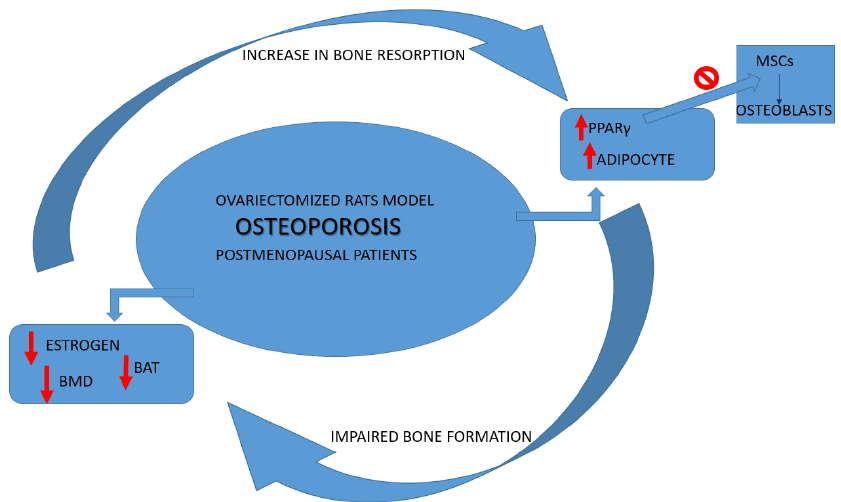
Figure 1. Osteoporosis cycle alterations. BAT: adipose tissue browning; PPARγ: proliferator-activated receptor gamma; BMD: bone mineral density; MSCs: marrow mesenchymal stem cells.